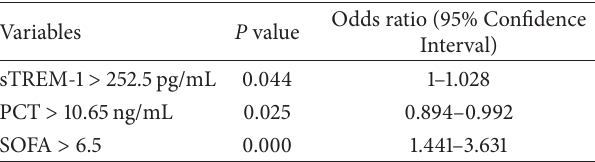
Table 4: Multiple logistic regression analysis of variables for predicting 28-day mortality.